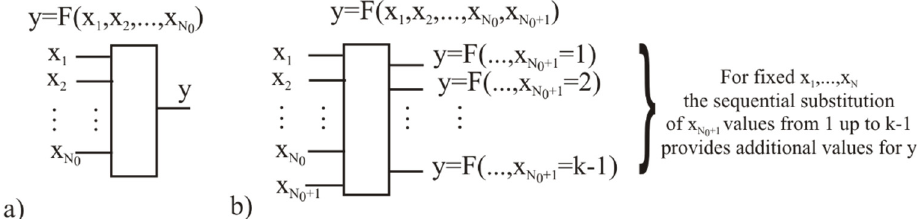
Figure 3. ( a ) The basic scheme to calculate function in AGA. ( b ) The simple scheme to use addi- tional counter 𝑥 (cid:3015)(cid:2868)(cid:2878)(cid:2869) in order to receive 𝑘 − 1 output values for the same set of input vectors given for MVL